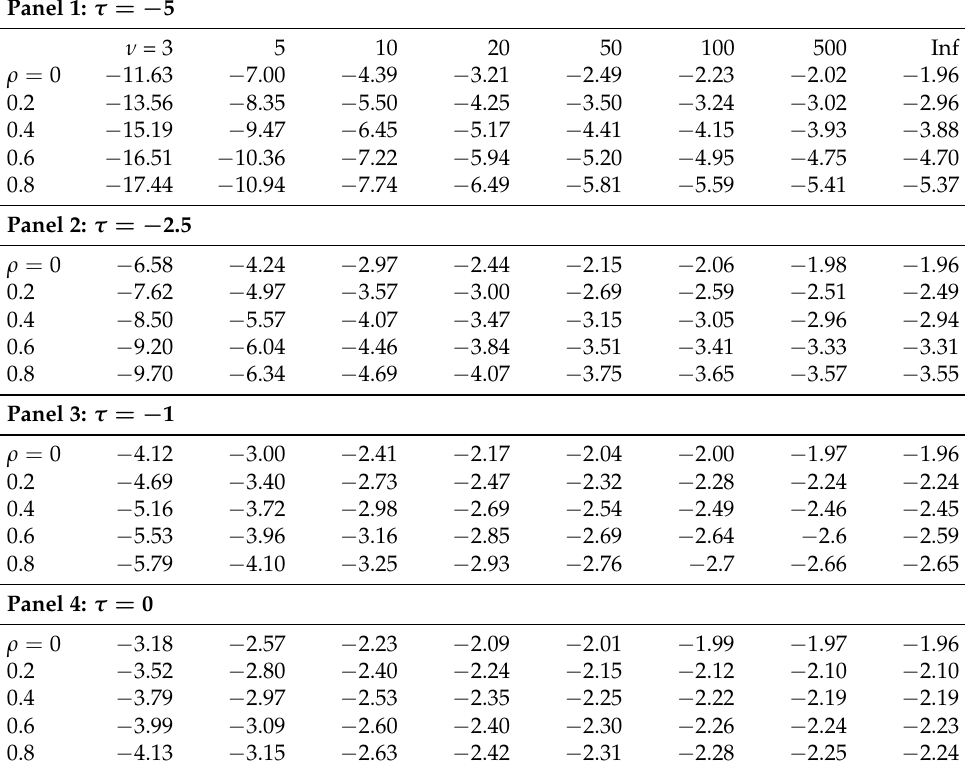
Table 10. Extended skew-normal and skew-Student critical values, p =